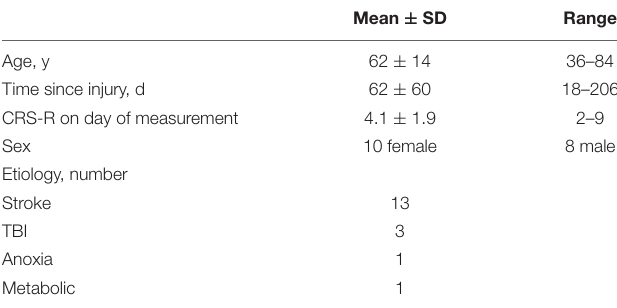
TABLE 1 | Clinical features of the unresponsive, wakeful